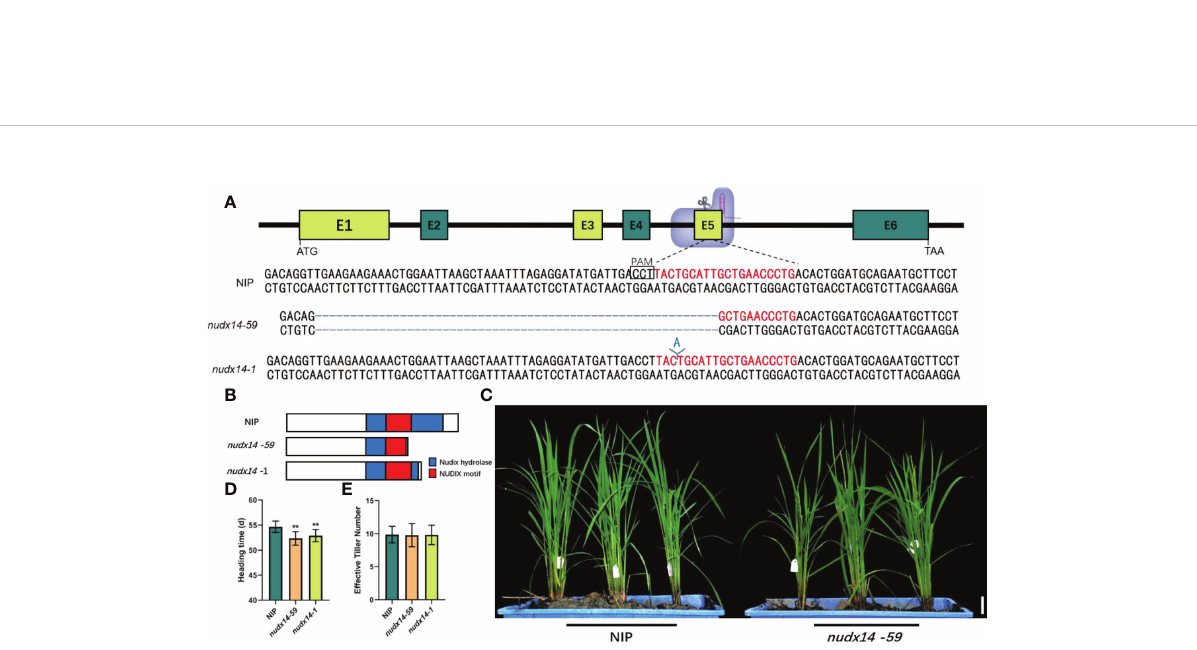
FIGURE 2 nudx14 plants showing early fl owering phenotype. (A) Sketch of the OsNUDX14 and single guide RNA target sites. The protospacer adjacent motif is shown in rectangle, and different nudx14 lines with deletions and insertions were con fi rmed by DNA sequencing. (B) 59 bp deletions (-59 bp) and 1 bp insertion (+1 bp) resulted in premature termination of OsNUDX14. (C) Phenotypes of wild-type (WT) and nudx14 plants at the reproductive stage. Scar bar: 5 cm. (D, E) Statistical analysis of heading time (D) and effective tiller number (E) between WT and nudx14 plants. Signi fi cance is determined by two-sided Student ’ s t test, **P <